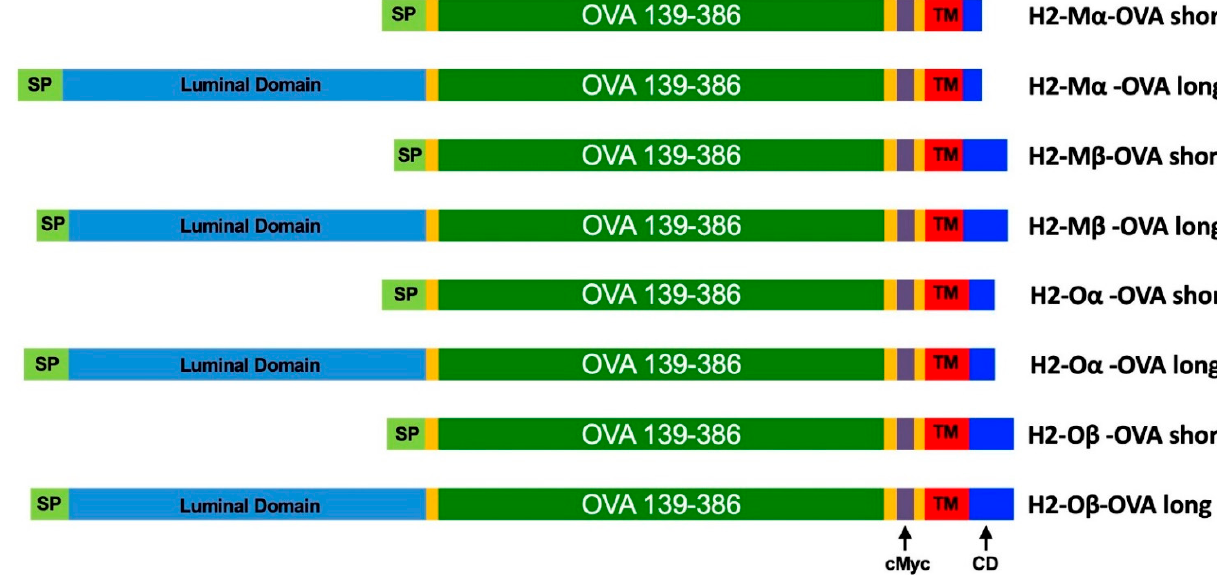
Figure 1. Schematic structure of mRNA-encoded H2-M OVA fusion protein constructs included in the study. Abbreviations: SP: Signal peptide (bright green), cMyc: cMyc epitope tag, TM: Transmembrane domain (red), CD: Cytoplasmic domain (dark blue). Yellow: Linker (GGGGS) sequences. Table 1. Fusion proteins used for murine T cell activation assays. Overview of the protein sequences selected for the study. Fusion